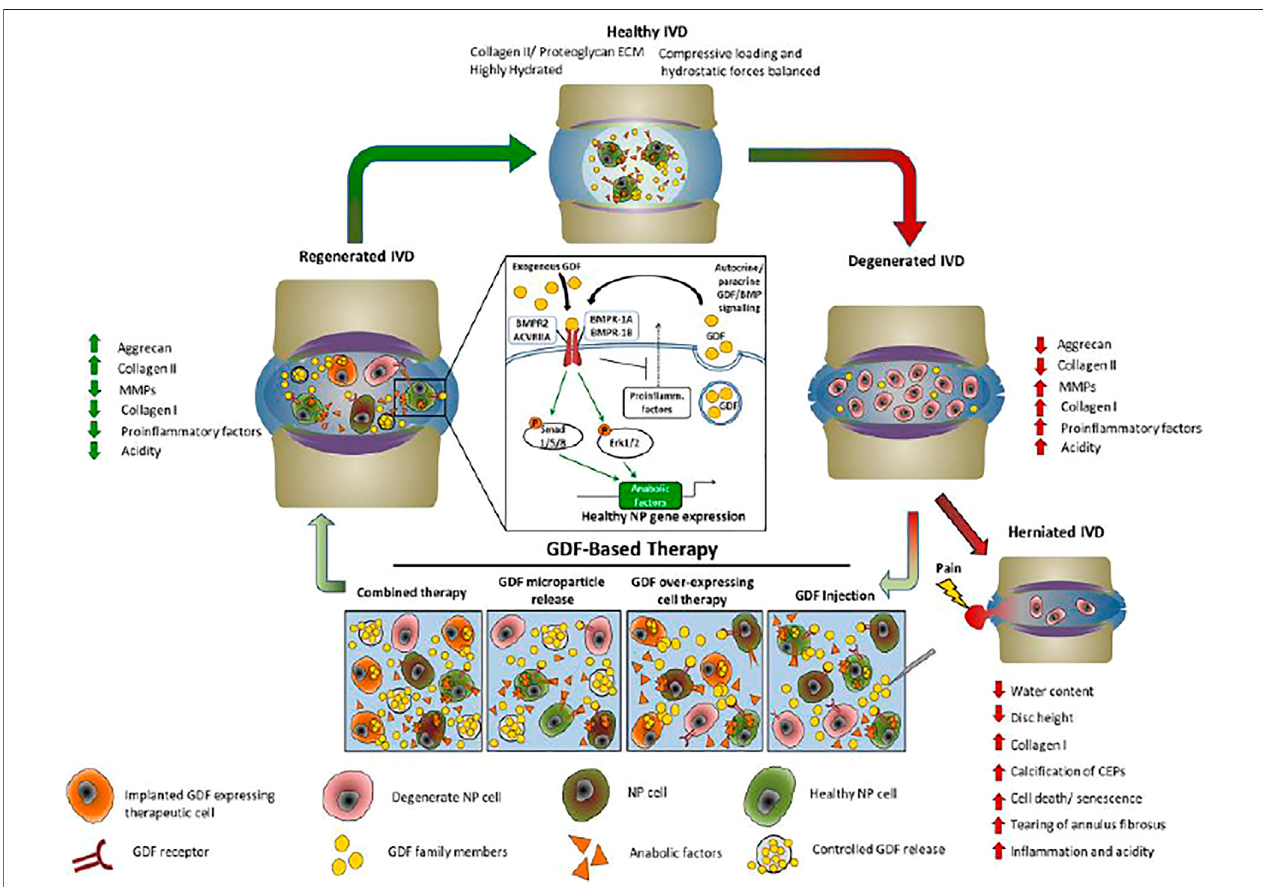
FIGURE 2 | The effect of GDF-based therapeutic cycle in IDD. The imbalance between synthesis and catabolism in normal IVDs and degenerate IVDs increase in fl ammationandalterECMproduction.TheprocessesaccelerateincreasingtypeIcollagenanddecreasingproteoglycanproduction,compromisestissueintegrity,and cause NP herniation and CLBP. Moreover, injection of GDF has shown promise for readdressing the balance between catabolic and anabolic processes in the degenerate IVD, thereby restoring disc matrix integrity and function, and reducing pain. ECM, extracellular matrix; GDF, growth differentiation factor; IVD, intervertebral disc; MMP, matrix metalloproteinase; NP, nucleus pulposus. Reproduced with permission (Hodgkinson et al., 2019). Copyright 2019,